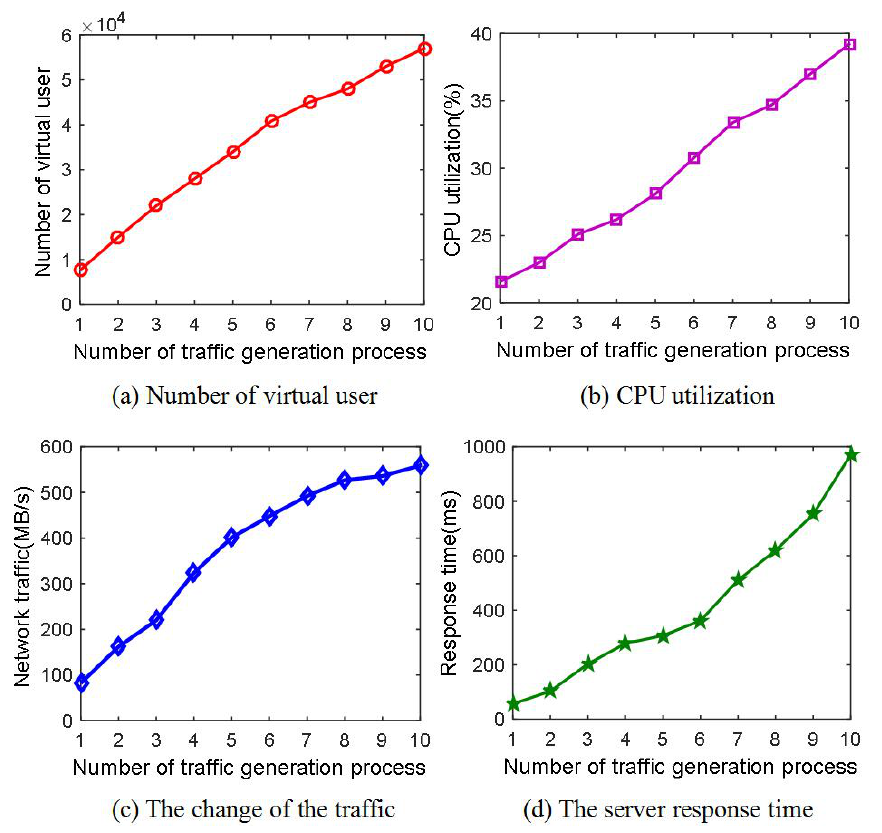
Figure 16. Many traffic generation